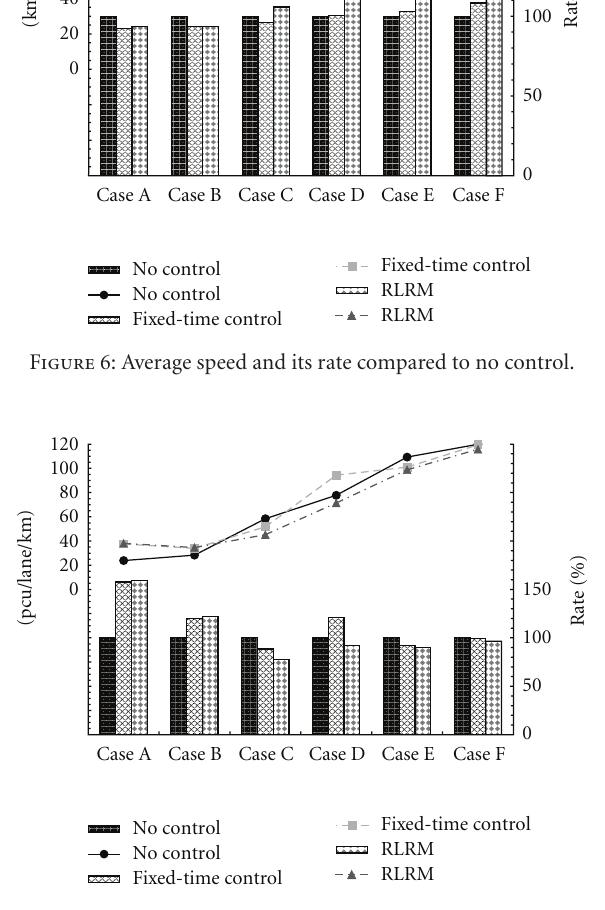
Figure 7: Density and its rate compared to no control.